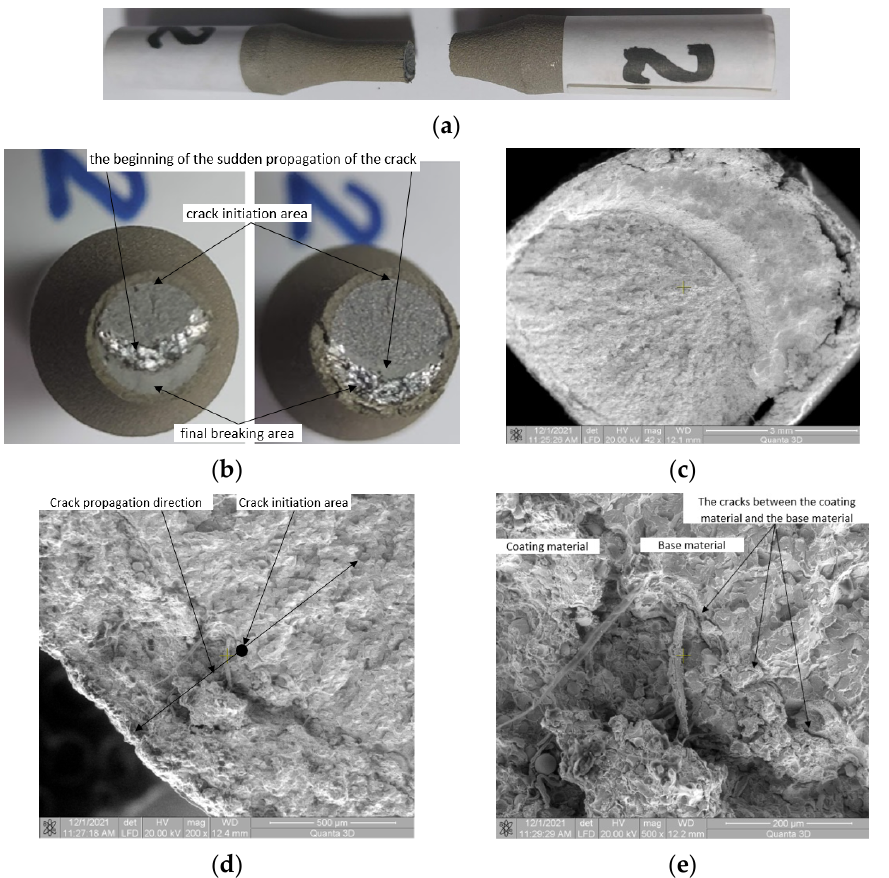
Figure 10. Macroscopic and microscopic appearance of broken surfaces for Sample 2, σ max = 636 MPa, N = 5300 cycles. ( a ) Sample 2 broken by fatigue. ( b ) Fracture surfaces. ( c ) SEM image of the surface at 42× magnification. SEM image of crack initiation region with ( d ) 200× and ( e ) 500× magnification.